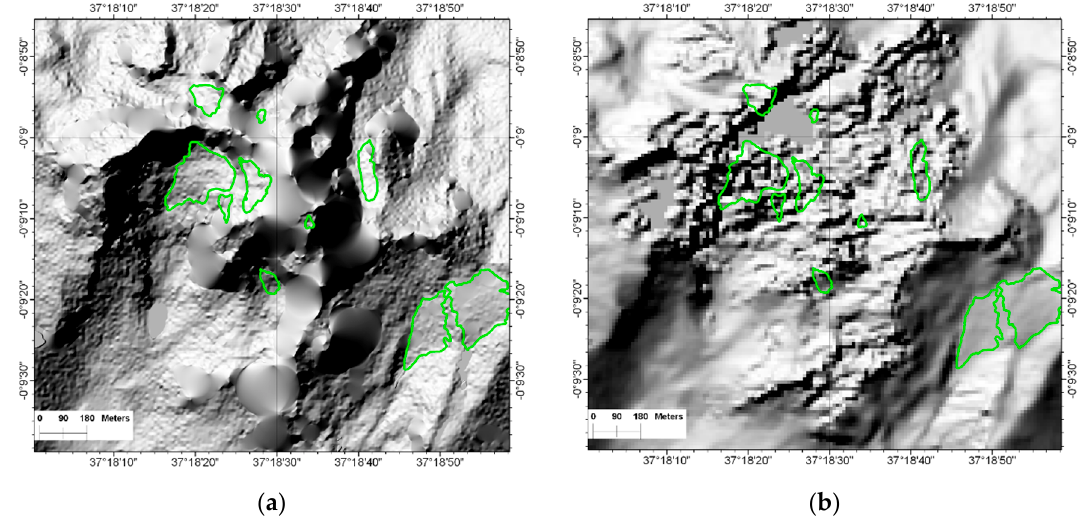
Figure 5. Comparison of the shaded reliefs from ( a ) PLE and ( b ) TDX showing errors in steep terrain and glacier outlines from 2016 in green. PLE errors are smoothed and restricted to steep walls, TDX errors are spread over the area with complex terrain, which is interpolated falsely as a rough surface or flat area. Lewis (lower right corner) is the only glacier not affected by DEM interpolation errors.